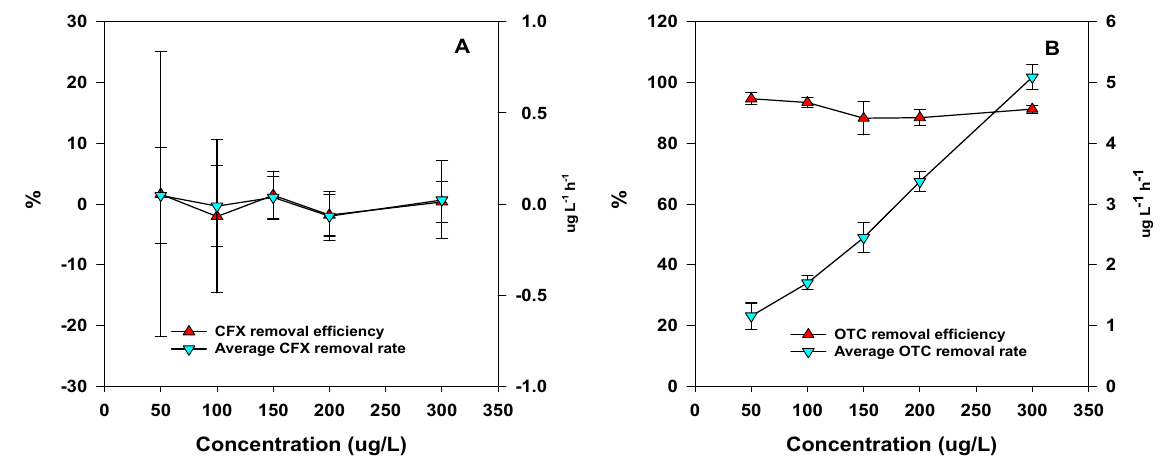
Figure 2. Degradation of CFX ( A ) and OTC ( B ) in the aerobic denitrification process.